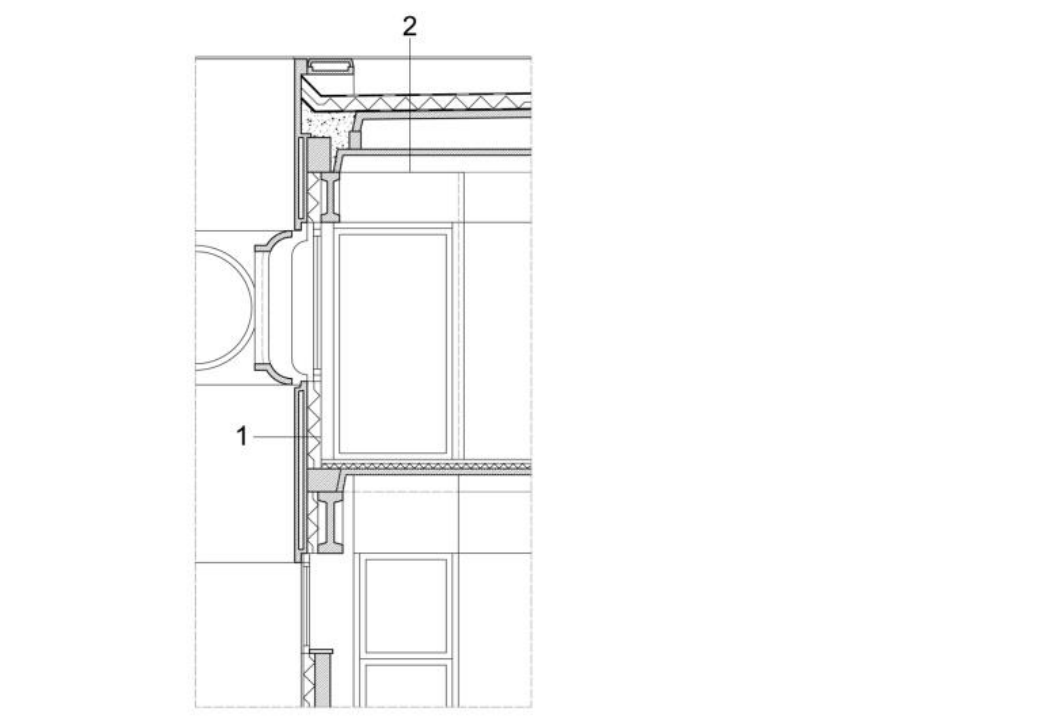
Figure 6. The commercial pavilion by Grunwaldzki Square—section. 1. The designed wall: reinforced